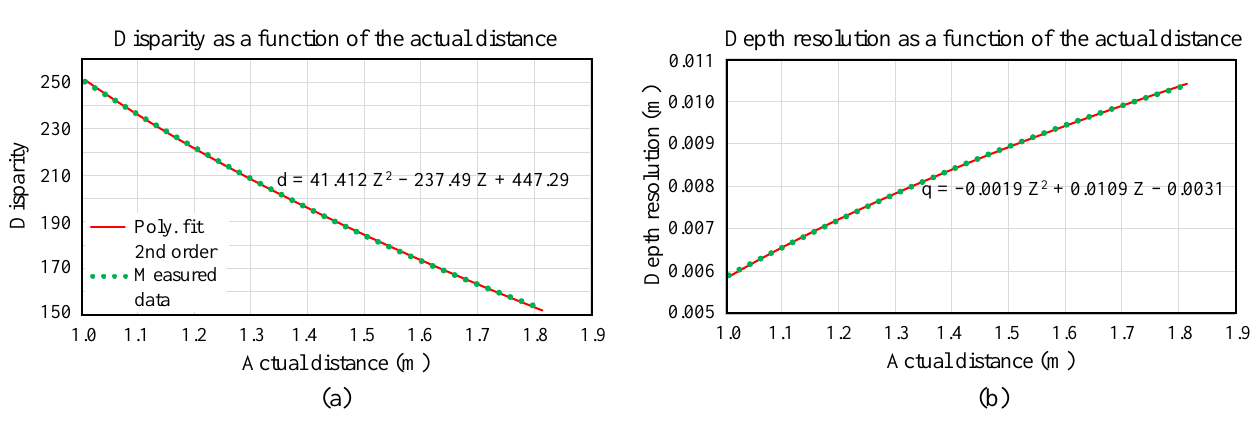
Figure 6. Estimation of the depth resolution of our stereo system as a function of the target distance from 1–1.82 m away from the camera: ( a ) Plot of disparities versus actual distances and ( b ) Plot of depth resolutions versus actual